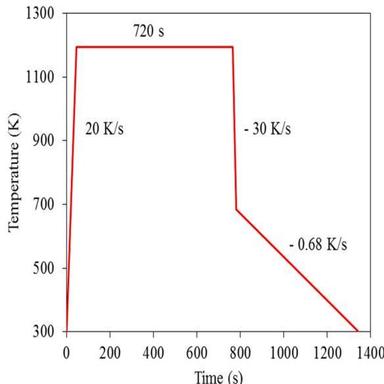
X100Q parent metal heat treatment profile used in precipitation kinetics simulations from Cheng et al. .